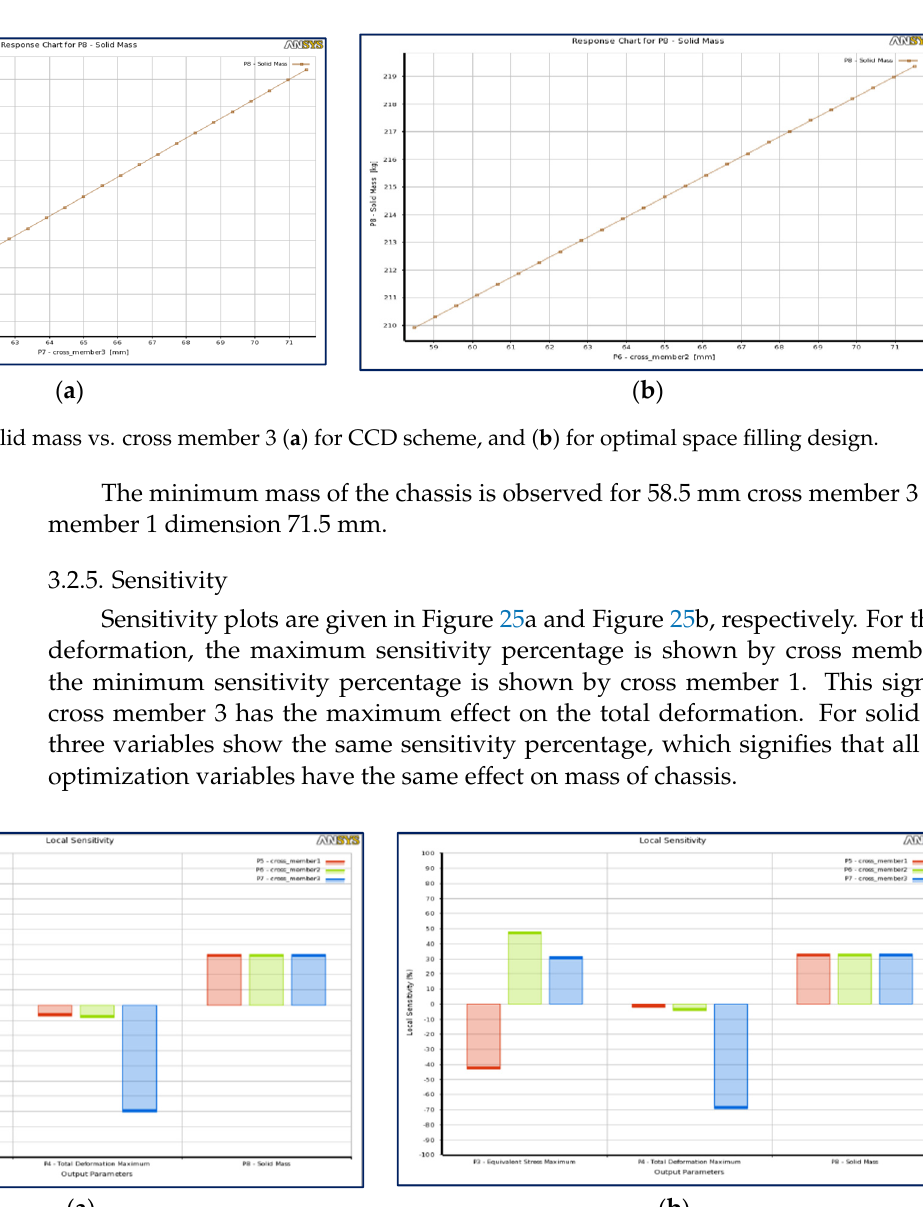
Figure 25 . Sensitivity plot ( a ) for CCD scheme, and ( b ) for optimal space filling design.